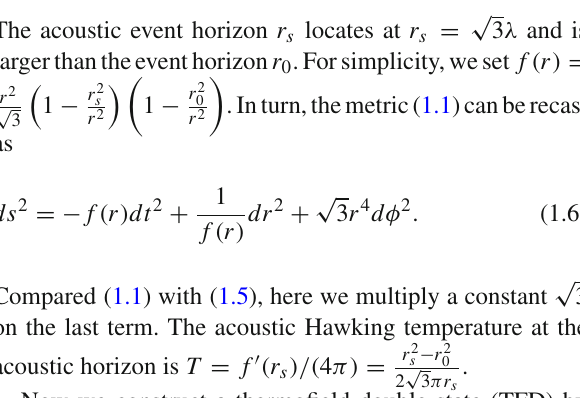
Fig. 1 The Penreos diagram of the acoustic AdS black hole [32]. The left and right blue lines and yellow lines respectively correspond to the AdS boundary and singularity. The dotted green lines correspond to the acoustic horizon, and the upper and lower oblique cyan lines stand for the event horizon G φφ = r 4